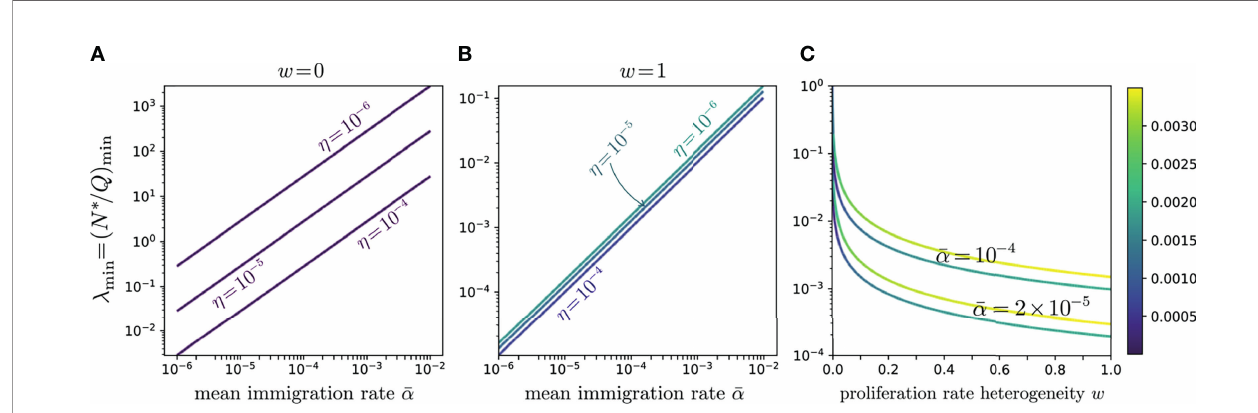
FIGURE 7 | Log-log plots of l min values as functions of a for h = 10 -4 , 10 -5 , 10 -5 , and 10 -6 for (A) the neutral model, w = 0, and (B) the full-width distributed proliferation rate model, w = 1. These curves trace the values of l min along the minimum valley in and show the relative insensitivity of the distributed proliferation rate model to the subsampling fraction h . In both (A, B) , the minimum line slopes are near one, with (B) showing a slightly greater slope, indicating l min is approximately proportional to (cid:2) a over the entire range of w . The color intensity along the lines in (A, B) indicates variation in the total error along the minimum valley; their uniformity shows that the errors are nearly constant along each line. (C) Log-linear plot of l min as a function of proliferation rate heterogeneity w for (cid:2) a = 2 (cid:4) 10 (cid:3) 5 ,10 (cid:3) 4 . The lower darker curves in each pair correspond to h = 10 -4 while the lighter curves correspond to h = 10 -6 . The curves show that even a small heterogeneity w quickly reduces l min to below one; however, if l is forced to be even smaller, the required heterogeneity w